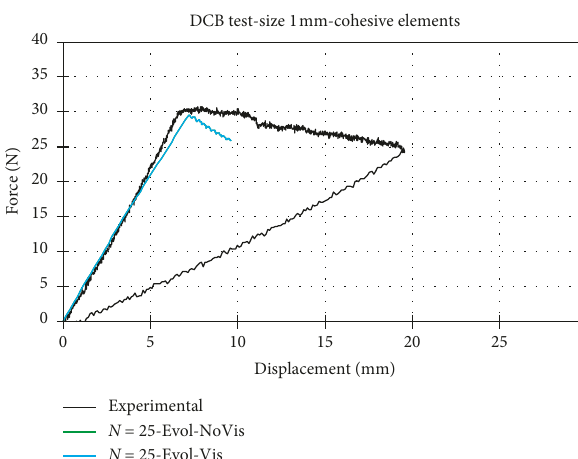
Figure 18: DCB test: cohesive elements (element size 1mm)—damage